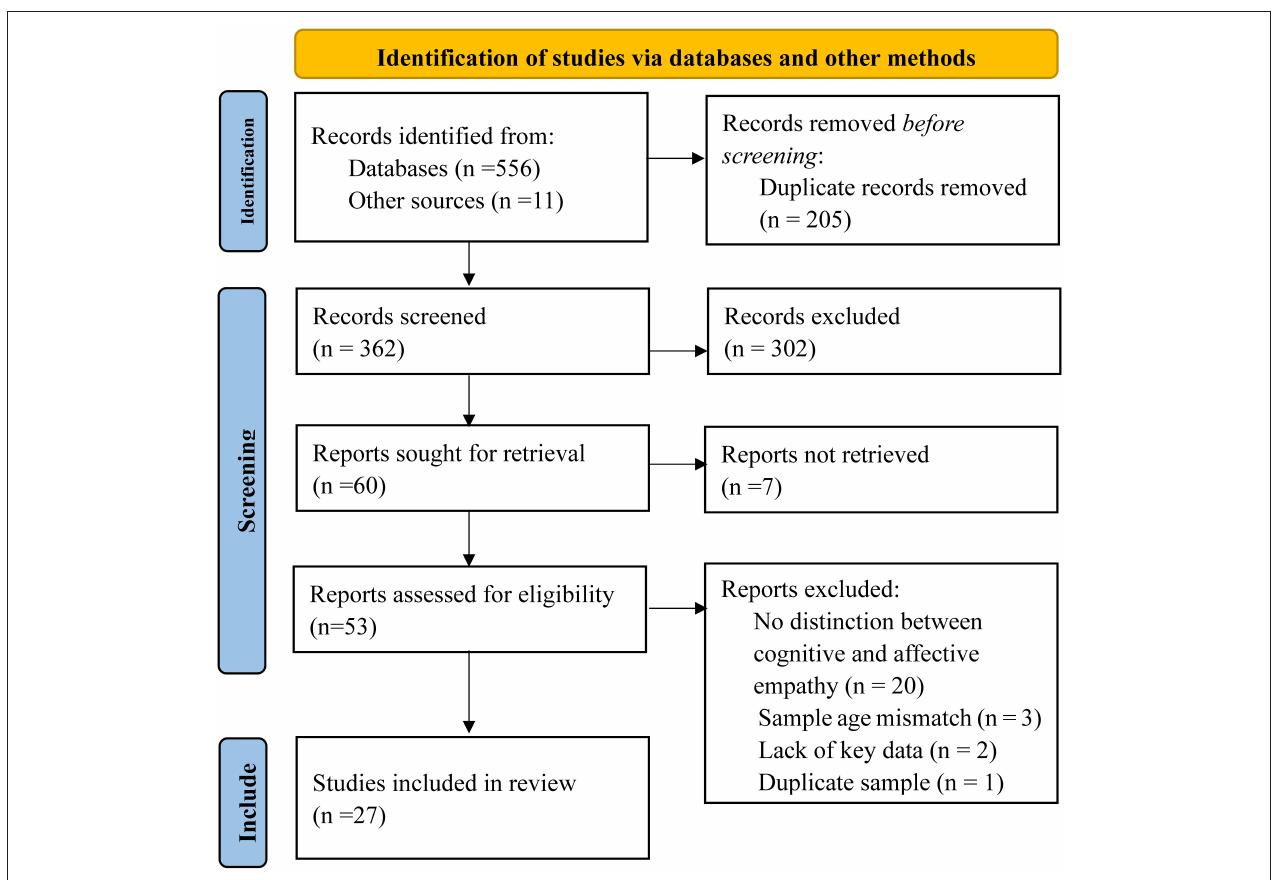
FIGURE 1 | Flowchart presenting the selection process of